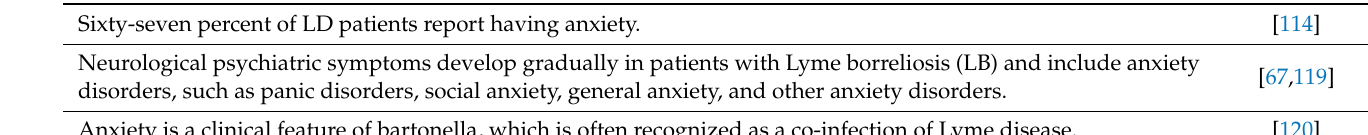
Table 13. Anxiety is not well studied in the medical literature as a symptom of TBDs, but is shown to be present with LD. TBRF is also associated with